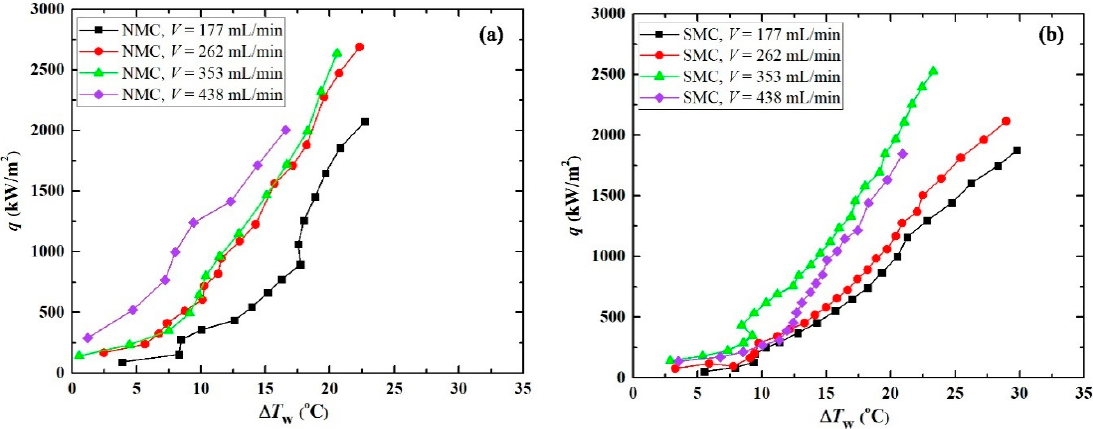
Figure 7. Boiling curves for ( a ) NMC and ( b ) SMC.